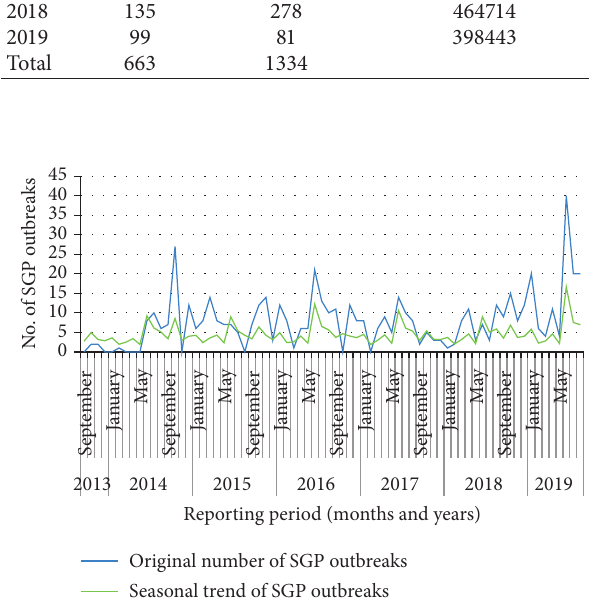
Figure 2: Monthly outbreak and trend of SGP outbreak from 2013 to 2019.